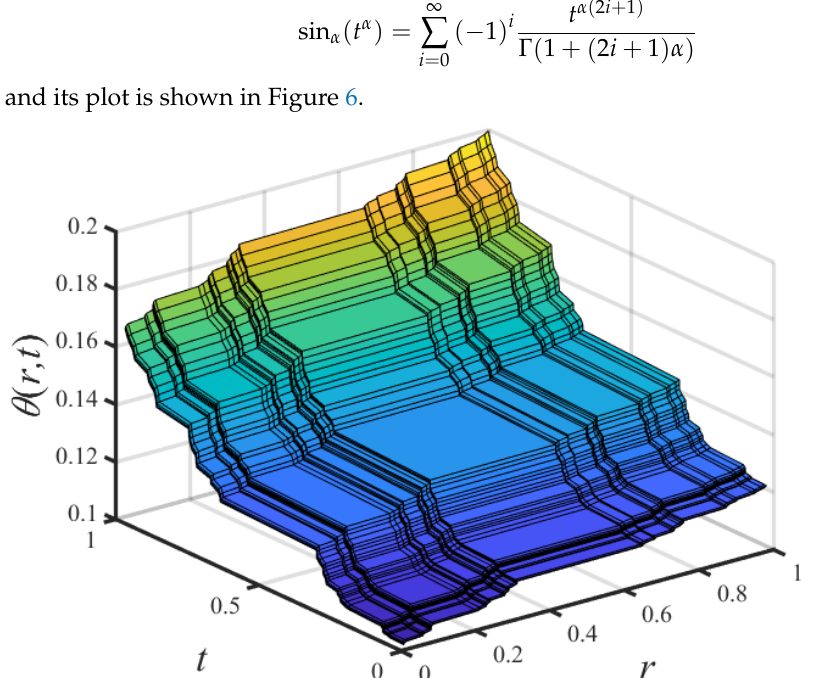
Table 1. Model parameters in computation of analytical model. Parameter